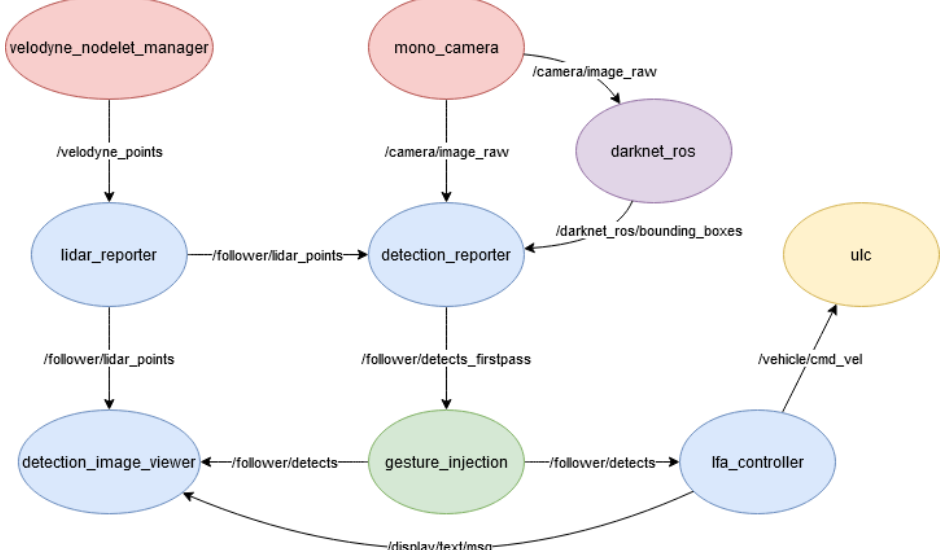
Figure 10. A diagram of the main ROS Nodes (ellipses) and topics (arrows) specific to our leader follower system. Nodes marked in red indicate hardware nodes which publish sensor data. Blue nodes represent helper nodes. The Darknet ROS node manages object detection, Gesture Injection runs the pose estimation and classification, and ULC manages interactions with the vehicle’s drive-by- wire